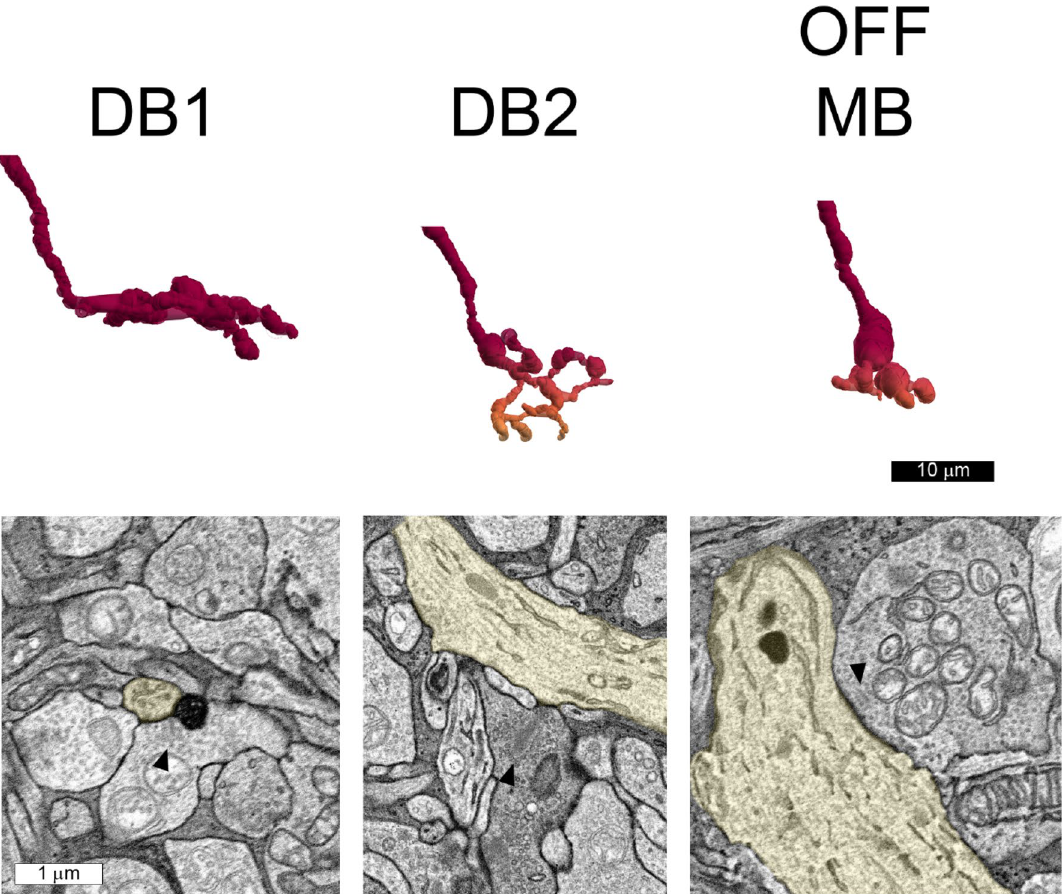
Figure 6. Three types of OFF bipolar cells made synapses onto displaced M1 ipRGC 11345 in the nasal volume. These include diffuse bipolar (DB) cell 1 (11369), DB2 (14615) and OFF midget bipolar (13313) cells. Their reconstructed and pseudocolored axon terminals are shown in the upper panel. Red indicates S1 and orange indicates S2. Note that none of the axon terminals extended into the inner half of the inner plexiform layer. The bipolar cell synapses onto ipRGC 11345 (yellow) are shown in the lower panels, and the synaptic ribbons are indicated ( ▲